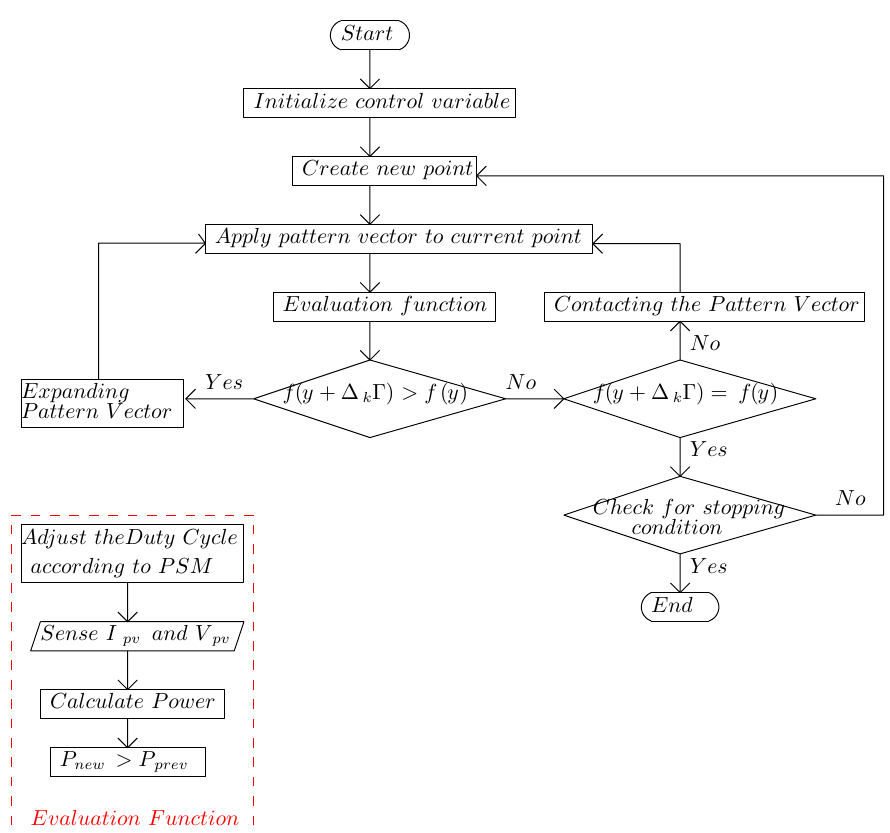
Figure 6. PSM (pattern search method) coordination.